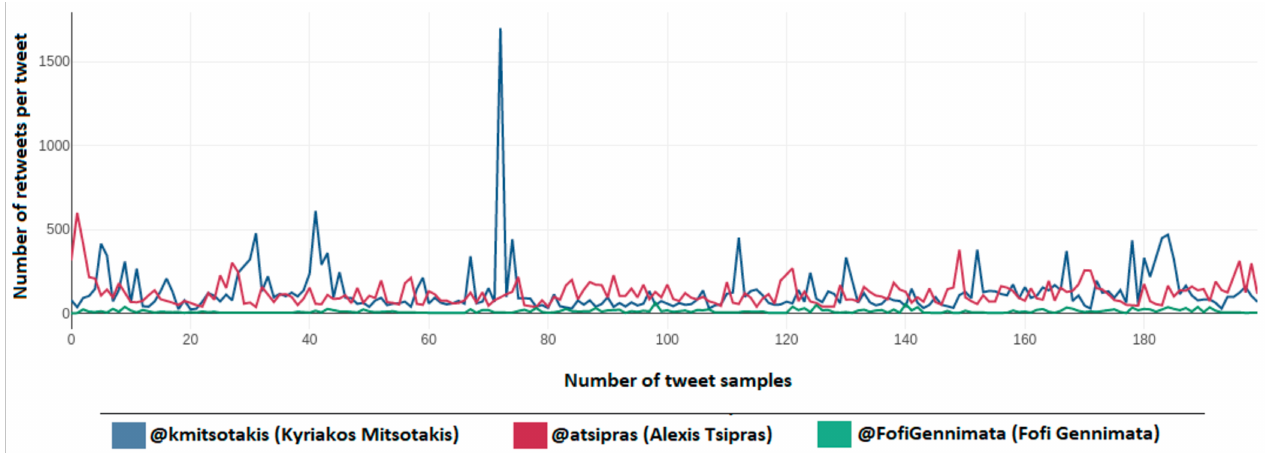
Figure 31. Comparison of user retweets per posted tweet for the top three Greek political leaders—600 tweet sample; 200 for each one of them (@primeministerGR is